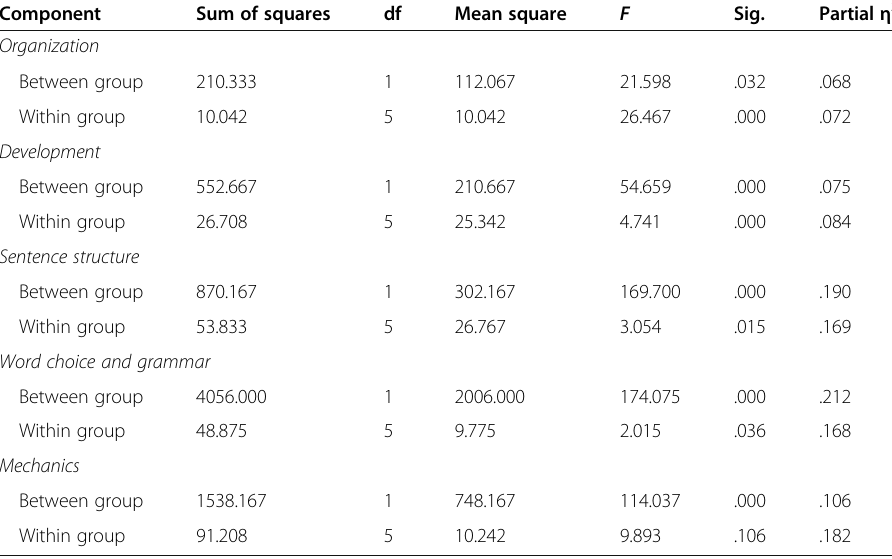
Table 7 RM ANOVA for higher-level and lower-level writing skills in narrative writing tasks Component